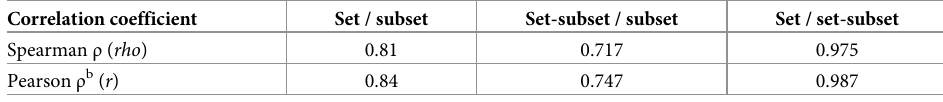
Table 2. Statistical analysis of daily COVID-19 infection data for Ireland as set and subset a